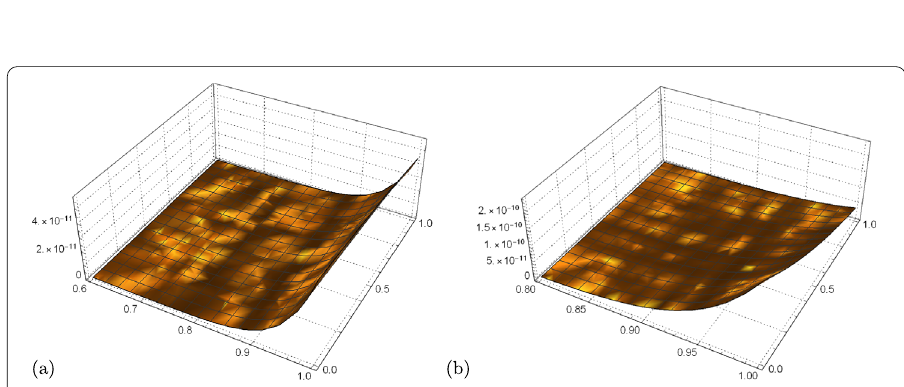
Figure 6 Solution of Example 3 using α = 0.99 and β = 0.98, (a) for u ( x , t ) and (b) for v ( x , t )